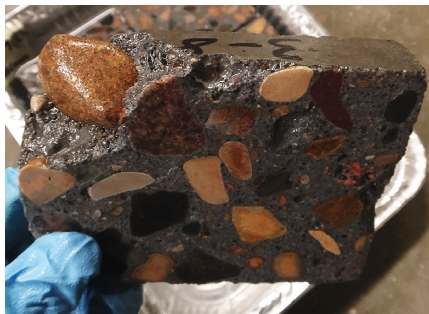
2 (calcium and sodium).